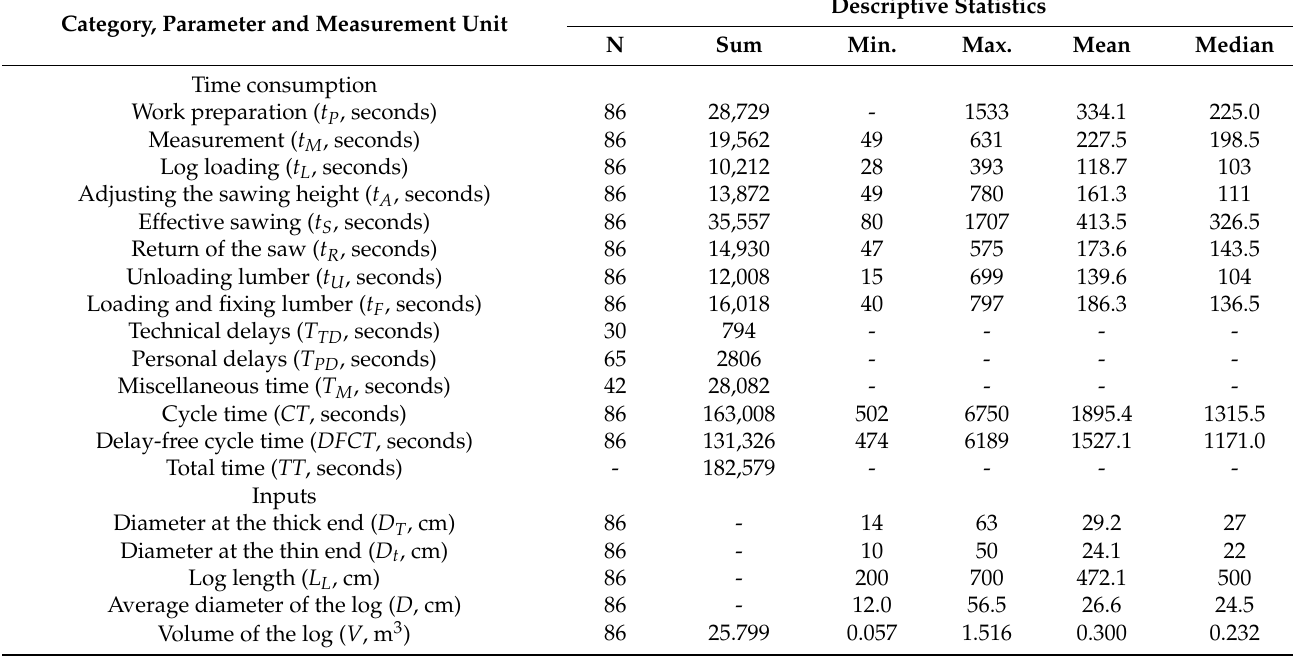
Table 2. Descriptive statistics of production inputs, outputs and